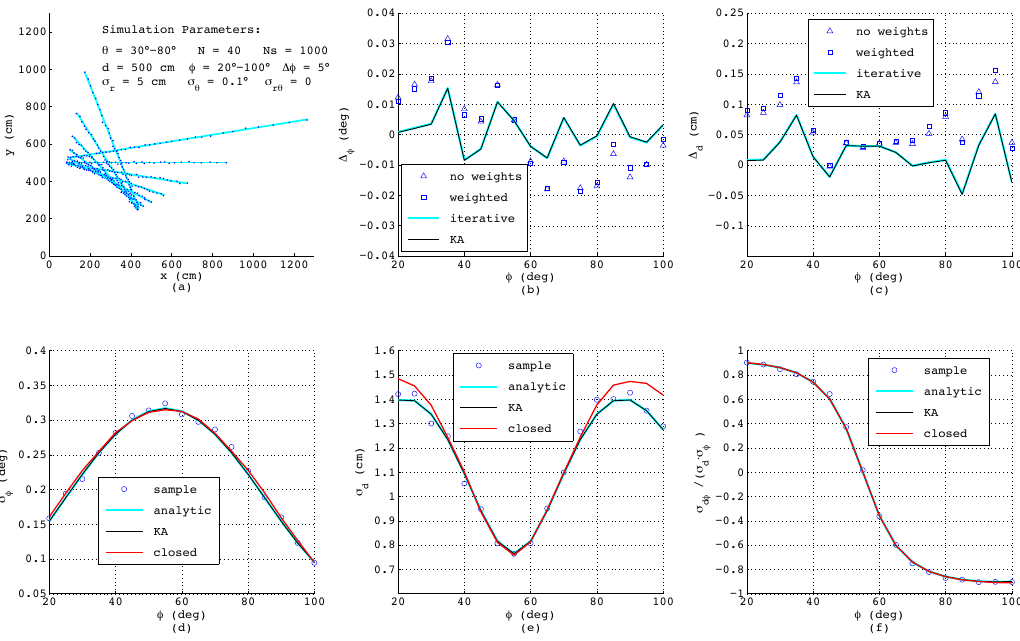
Figure 7. Results from simulated range-bearing scans superimposing low noise in the r - and θ